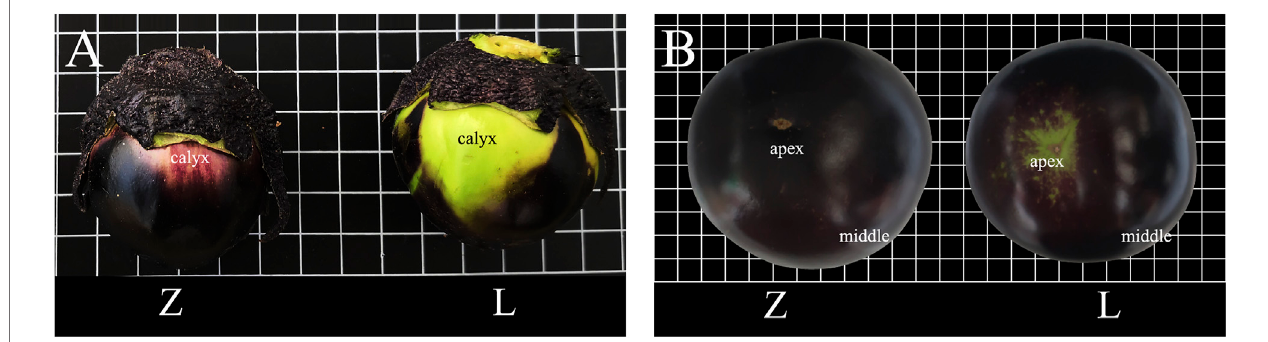
FIGURE 1 | The two inbred eggplant ( Solanum melongena L.) lines, Z and L. (A) Peel color under the calyx of Z and L fruits. (B) Peel color at the apex of Z and L